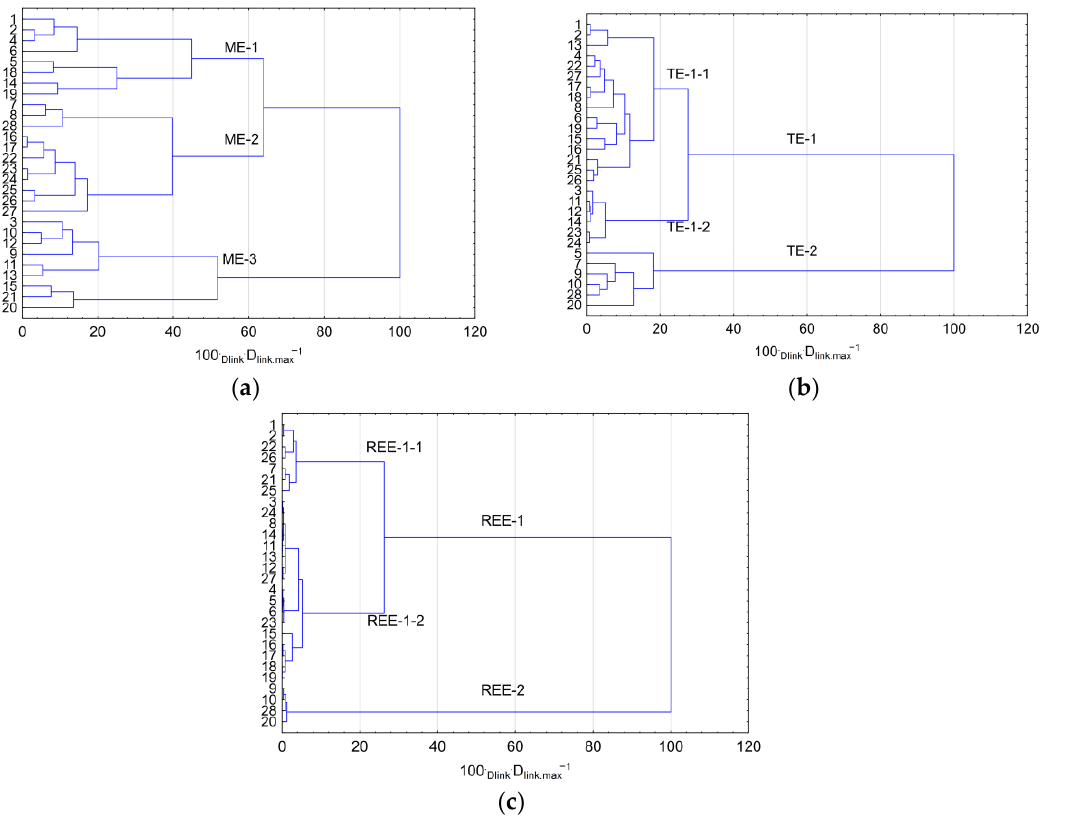
Figure 3. Grouping of springs based on similarities in concentrations of ( a ) MEs; ( b ) TEs; ( c )